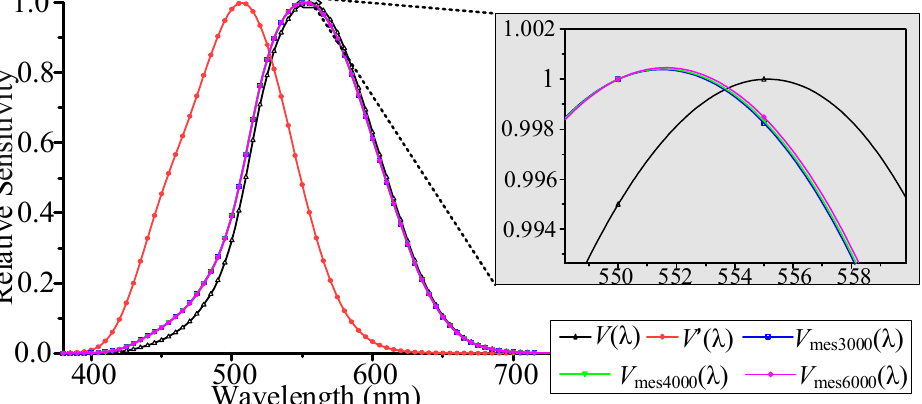
(cid:48) ( λ ), and V Figure 4. V ( λ ), V ’ ( λ ), and V mes ( λ ) for LEDs with different CCTs. Figure 4. V ( λ ), V mes ( λ ) for LEDs with different CCTs. Figure 5 plots the percentage difference value curves between mesopic luminance and photopic luminance against the photopic luminance with three LED light sources. It can be found that the difference is a positive value, which indicates that mesopic luminance obtained with LED luminaires is considerably higher than photopic luminance, especially for low photopic luminance. For example, for an L p = 0.1 cd/m 2 , L mes would be for 3000 K LED 19.94% higher ( L mes = 0.12 cd/m 2 ); for 4000 K LED 26.5% higher ( L mes = 0.1265 cd/m 2 ) and 6000 K LED 37.17% higher ( L mes = 0.1372 cd/m 2 ).